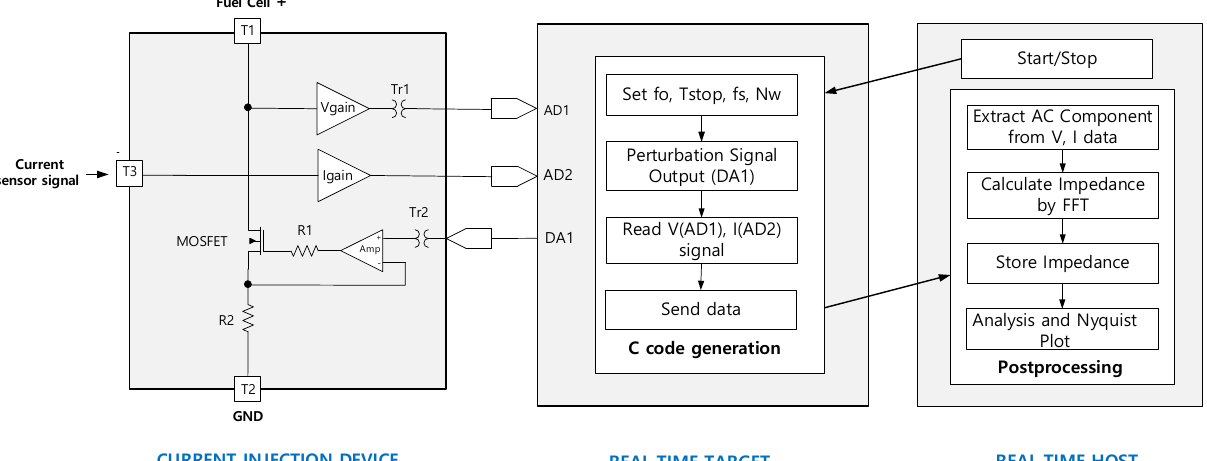
Figure 3. Building on-line EIS by real-time target.